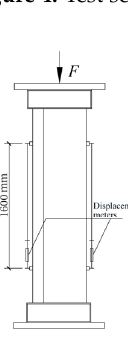
Figure 6. The arrangement of strain gauges.